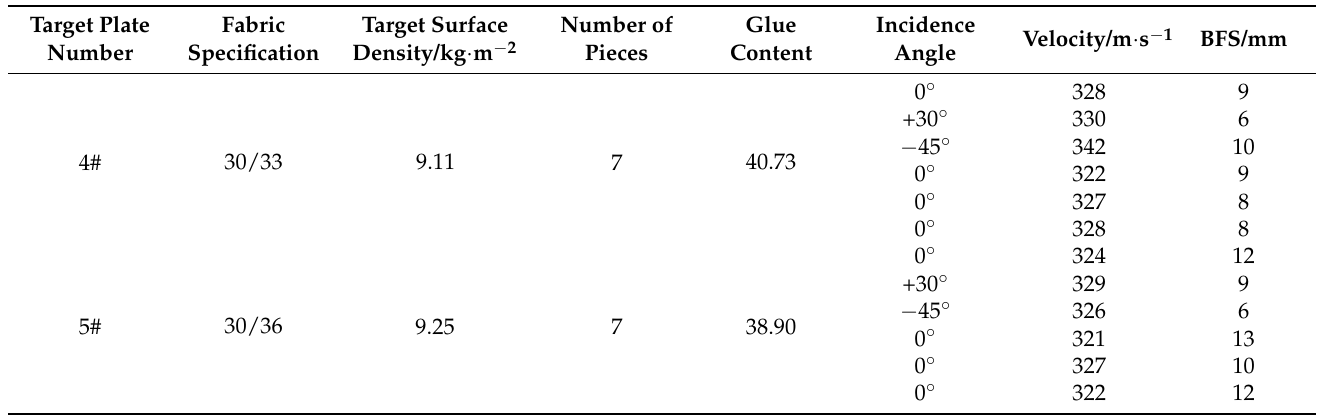
Table 4. Ballistic test results of 3DPPAI Kevlar/EP armor materials of class